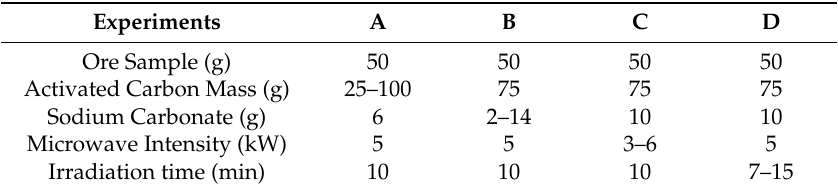
Table 1. Experimental conditions of the reductive microwave roasting (RMR).